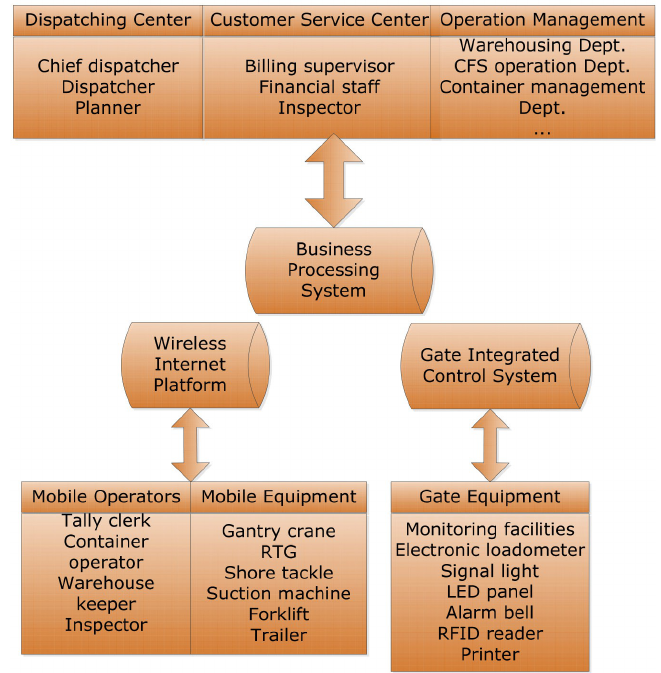
Figure 3. Operation system